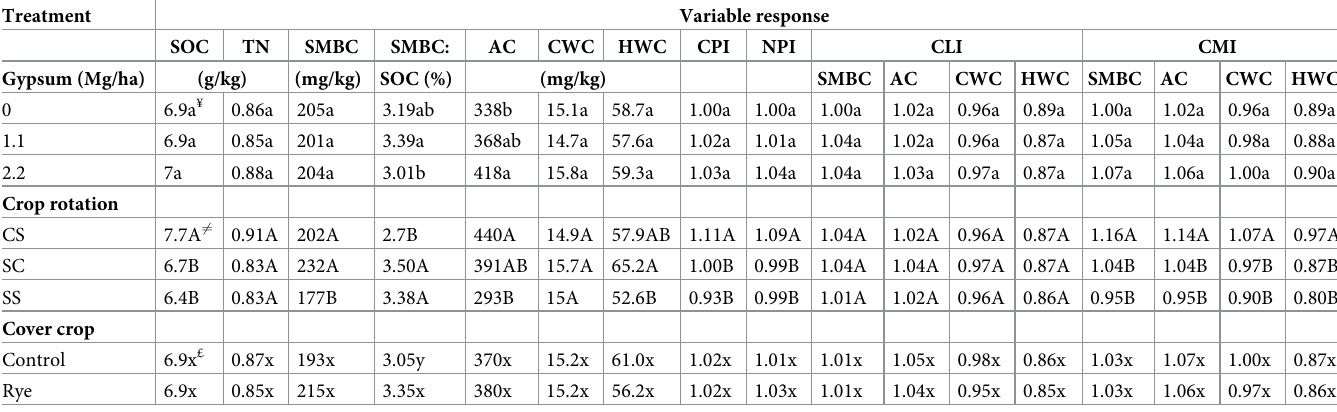
Table 4. Gypsum and cover crop impacts on total soil organic C (SOC), total nitrogen, microbial biomass (SBMC), active carbon (AC), cold (CWC) and hot (HWC) salt solution extractable carbon, carbon pool index (CPI), nitrogen pool index (NPI), carbon lability index (CLI) and carbon management index (CMI) under differ- ent phases of a rainfed no-till soybean-corn rotation in Ohio-Piketon (2012 to 2016).